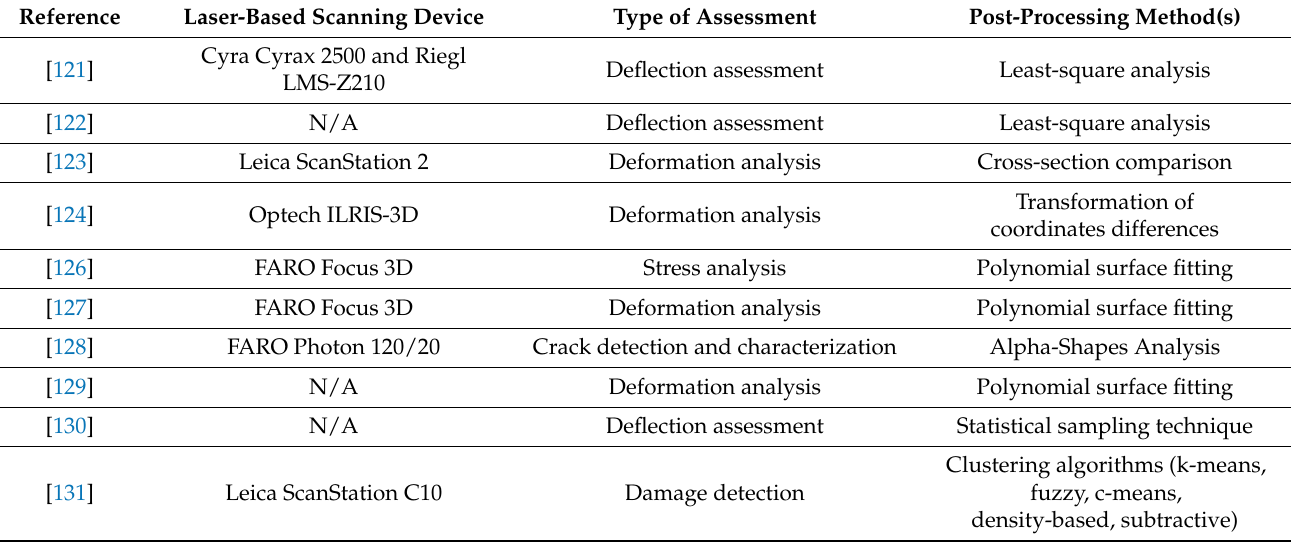
Table 9. A comprehensive summary of laser-based assessment techniques for other structural